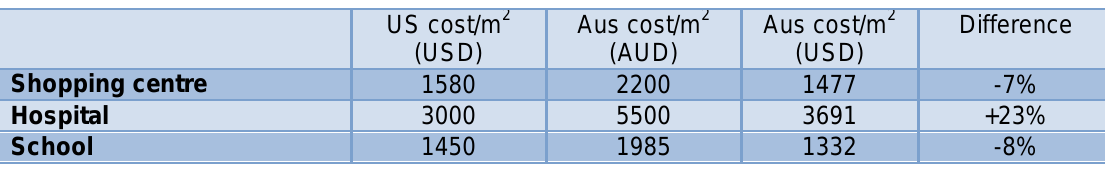
Table 4 2008: Turner & Townsend data, GDP PPP (1.49AUD=1USD) (OECD